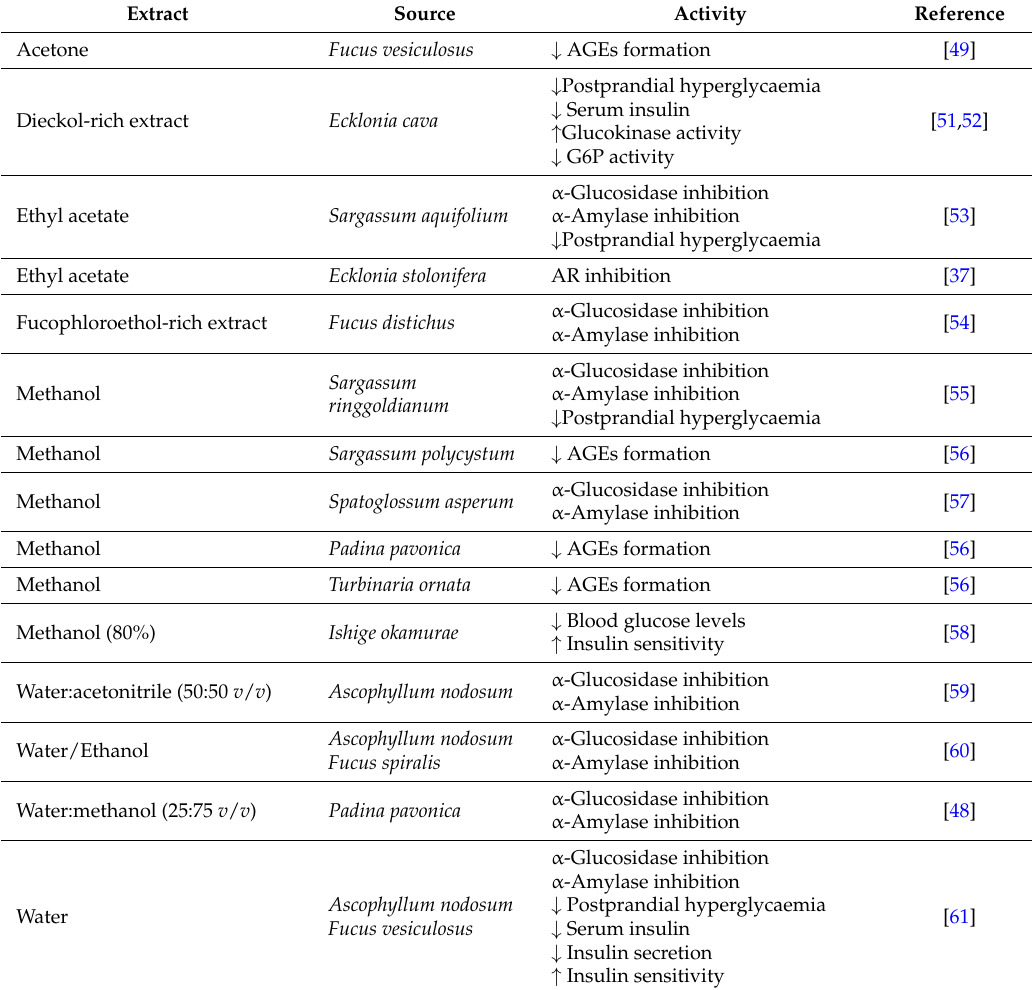
Table 2. Antidiabetic activity of phlorotannin extracts